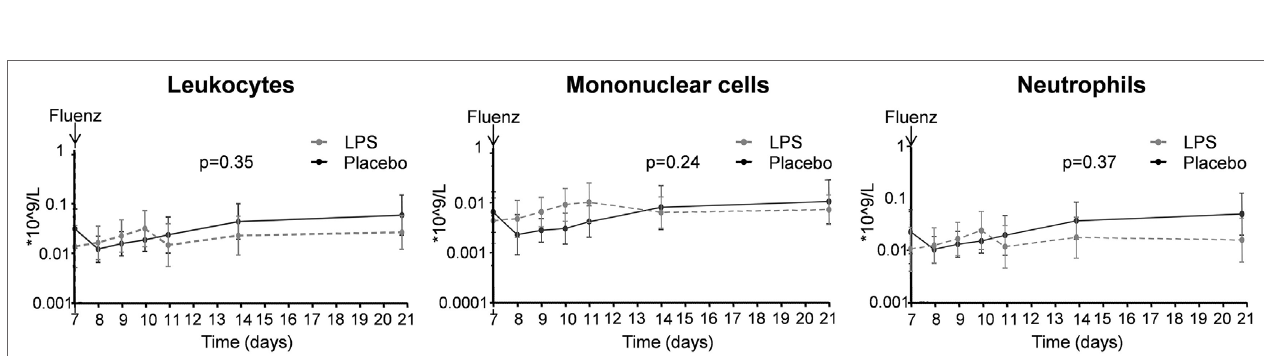
FigUre 11 | Total leukocyte counts, numbers of mononuclear cells, and neutrophils in nasal wash in the 26 subjects who were challenged with lipopolysaccharide (LPS) ( n = 13) or placebo ( n = 13) on day 0 and displayed infectivity after inoculation with Fluenz on day 7. Data are represented as geometric mean with 95%